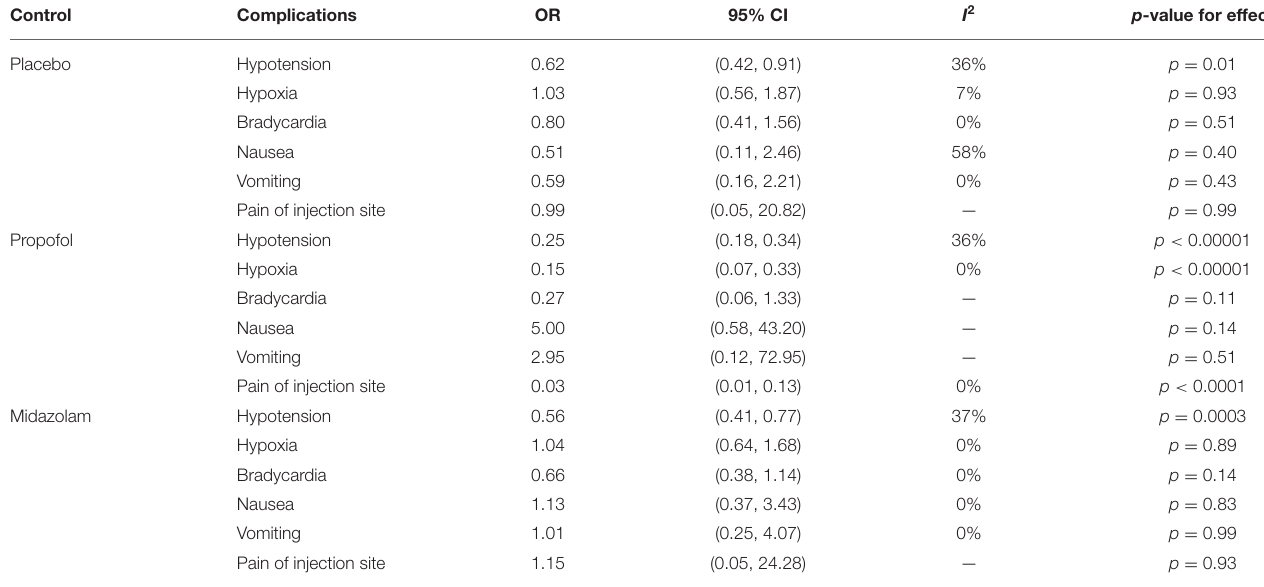
TABLE 4 | The pooled results of adverse events rates between remimazolam group and control group. Control Complications OR 95% CI I 2 p -value for effect Placebo